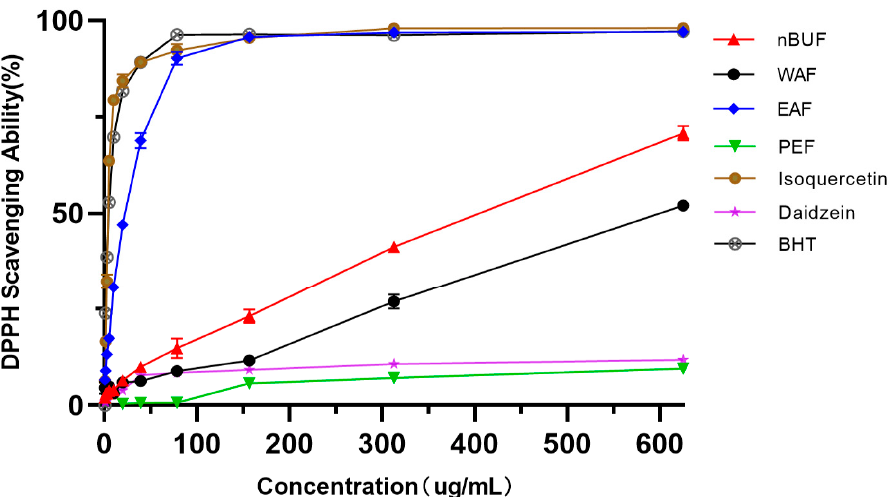
Figure 2. The DPPH scavenging abilities of different preliminary purification fractions and stan- dard